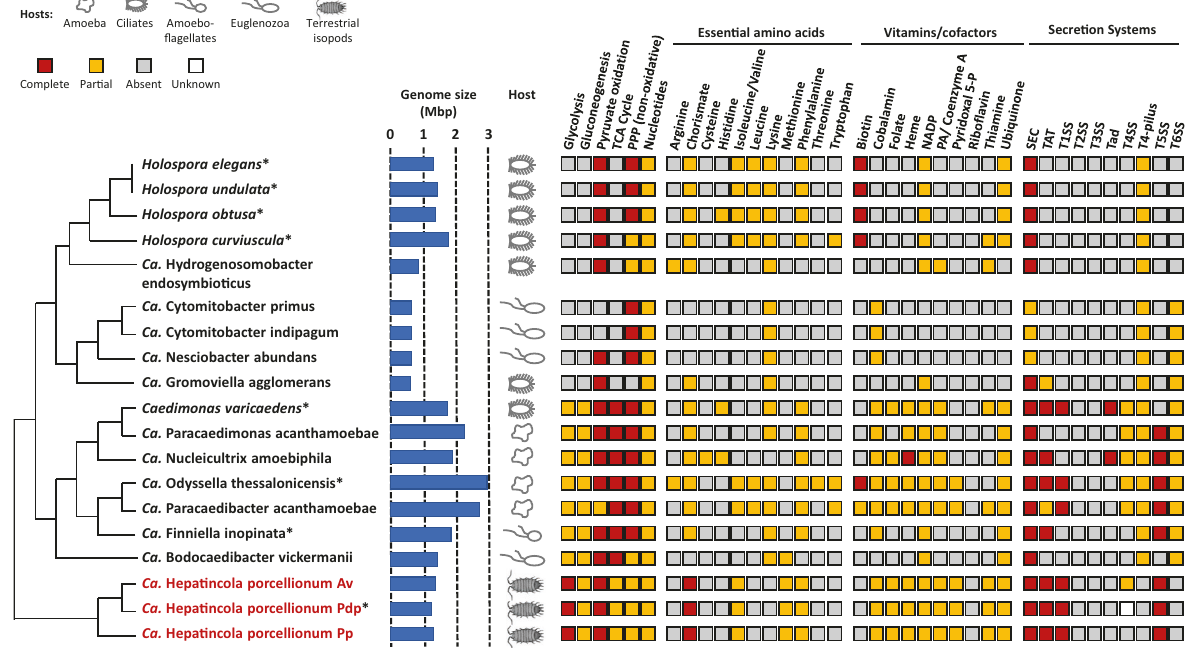
Fig. 6 Metabolic capacity of Hepatincola compared to other Holosporales . KEGG pathway comparison shows that Hepatincola has limited metabolic capacities different from other Holosporales families, notably regarding glycolysis, biosynthesis of essential amino acids, vitamins and cofactors as well as secretion systems. Genome sizes and host organisms are indicated. Complete, partial, absent or unknown (due to missing genomic region in the HepPdp draft genome) KEGG pathways are indicated in red, orange, gray and white respectively. Asterisks indicate draft genomes. Phylogenetic relationships are represented based on Fig. 4 and not to scale. PPP pentose phosphate pathway, PA pantothenic acid, Pyridoxal 5-P pyridoxal 5-phosphate, TxSS type x secretion